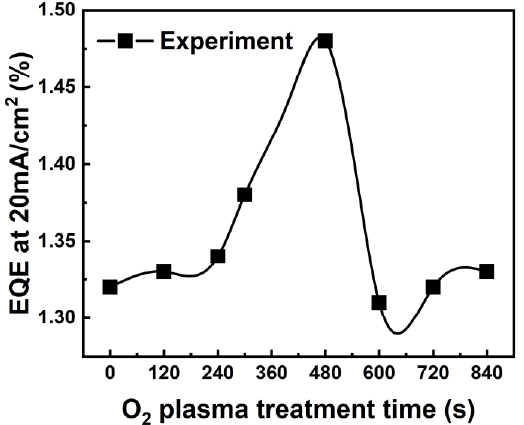
Figure 4. EQE characteristics as a function of current density: The OLEDs fabricated with varying the O 2 plasma treatment duration to analyze the effect of the external light extraction film on the device characteristics.